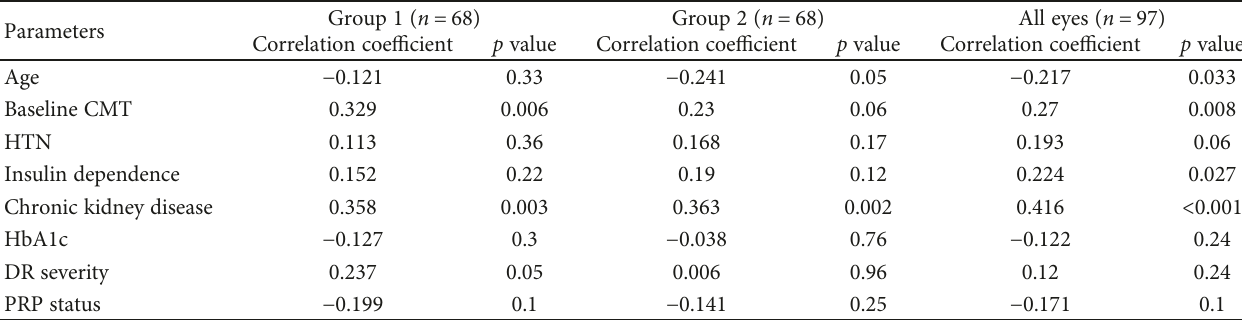
Table 1: Correlations of subretinal fl uid with baseline clinical parameters.